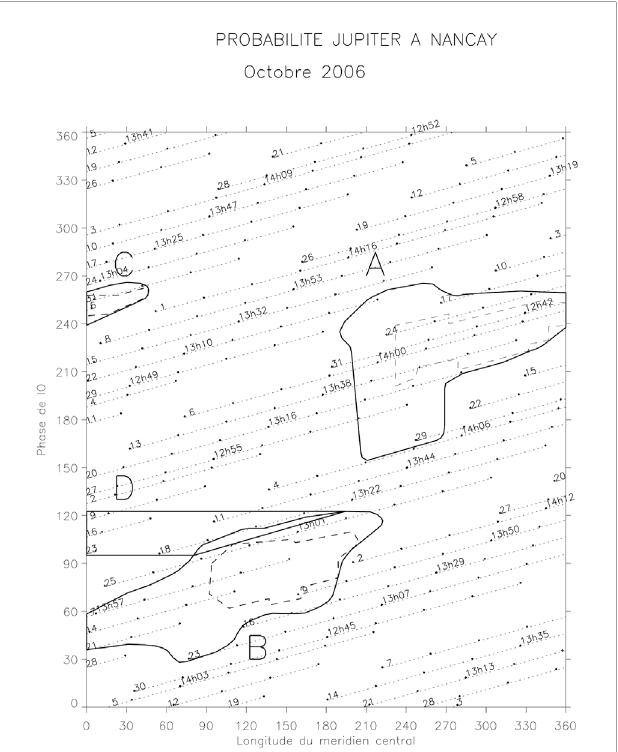
FIGURE 1 NDA provided probability maps for Io-controlled Jovian radio emission, on October 2006. The figure presents the observer’s CML on the horizontal axis, and the Io phase on the vertical axis. The dotted lines are the trajectory of the observer in this plane. At the start of each dotted line, the starting day of month of the line is indicated. Each dotted line covers 8 h. The transit time of Jupiter is also provided on the middle tick along this trace. The labels and titles are in